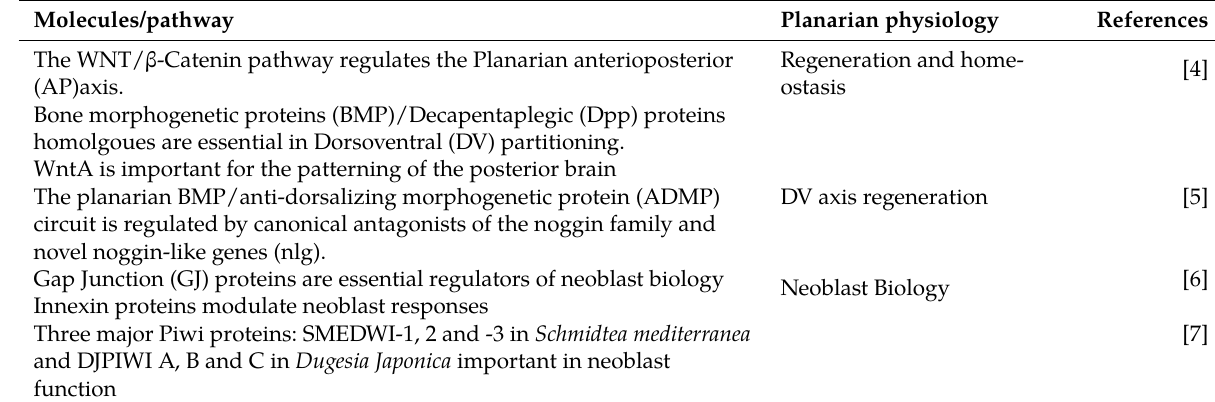
Table 2: Molecules and pathways associated with Planarian regeneration.